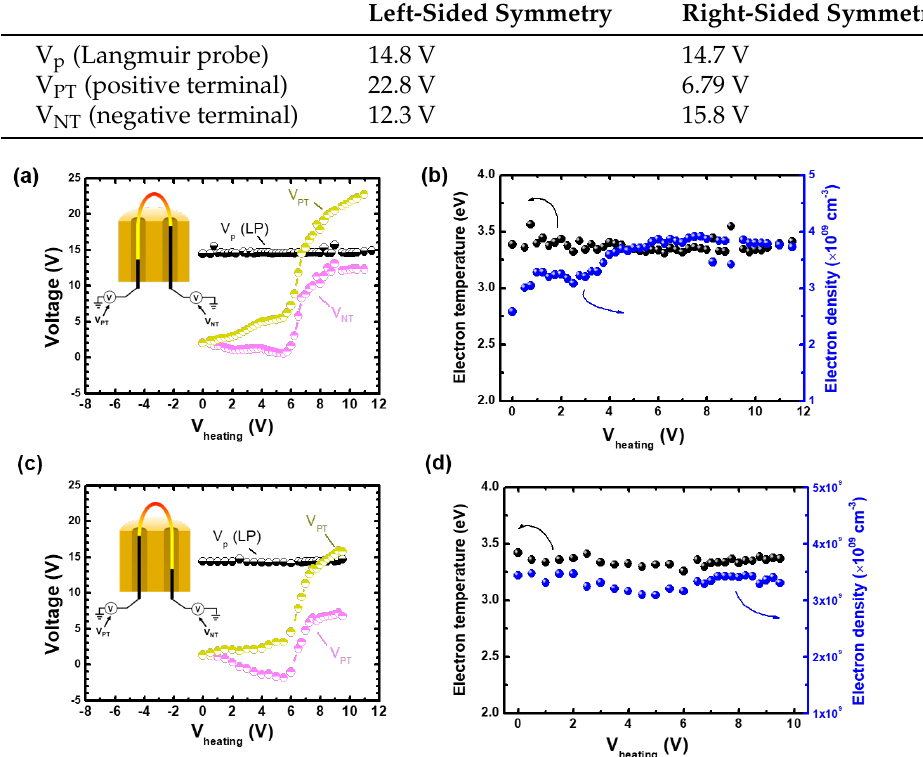
Figure 5. ( a , c ) Measured plasma potential (V p (LP)) obtained with Langmuir probe, positive and negative potentials (V PT and V NT ) obtained with the emissive probe, and ( b , d ) measured electron density and temperature obtained with the Langmuir probe with different emissive probe symmetry: ( a , b ) left-sided and ( c , d ) right-sided